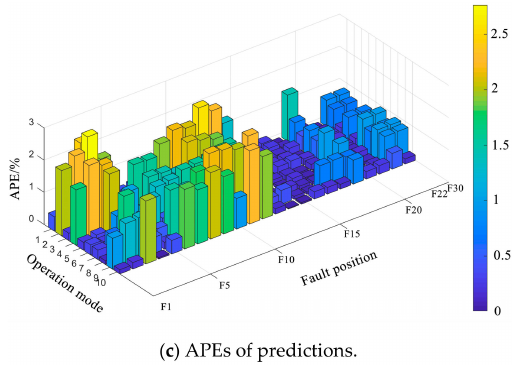
Figure 4. Prediction results in di ff erent operation modes. Table 3. Number of prediction in each range of absolute percentage error (APE).